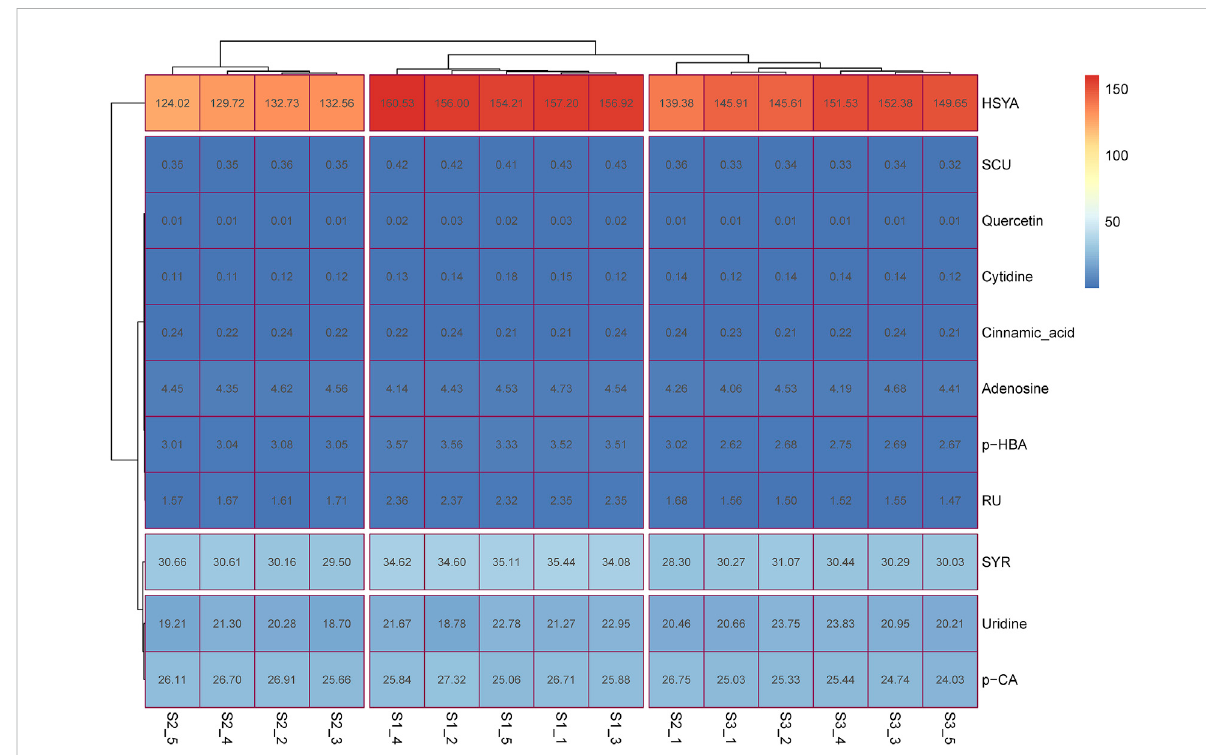
FIGURE 1 The heatmap for content determination results of multiple ingredients in SI. S1-1 to S1-5, S2-1 to S2-5, and S3-1 to S3-5 represent the fi ve SI samples from the three batches of preparations (Nos. 19050511, 18113011, and 18101511, respectively); the number in each box represents the content of the relative ingredient in the corresponding sample with the unit of μ